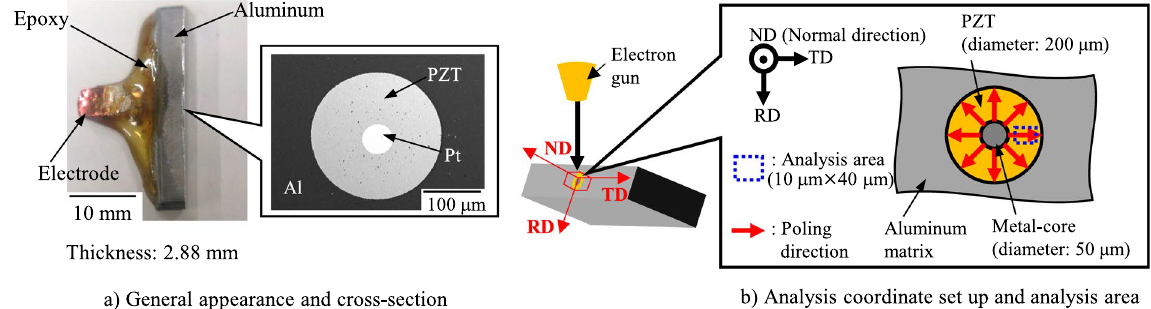
entation analysis) and b Cartesian coordinate system showing the normal direction (ND), rolling direction (RD), transverse direction (TD), and analysis